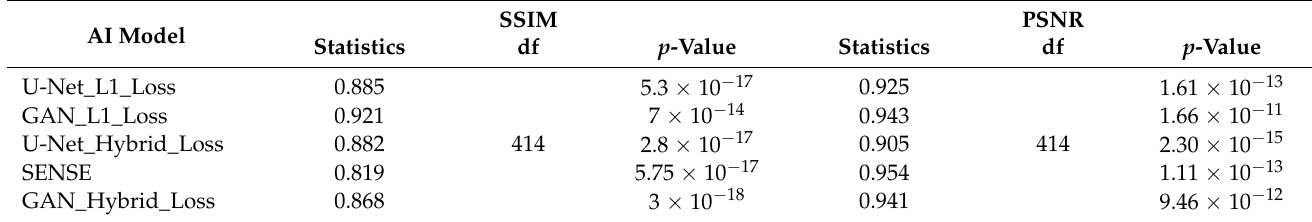
Table 3. Shapiro–Wilk normality test for SSIM and PSNR of studied AI